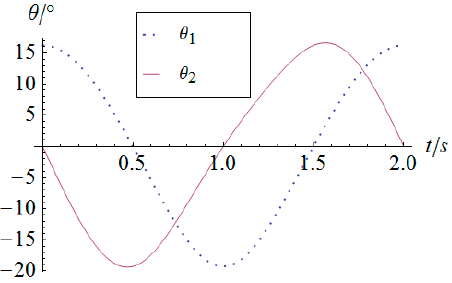
Figure 12. Angular displacement vs. time of the actuators.